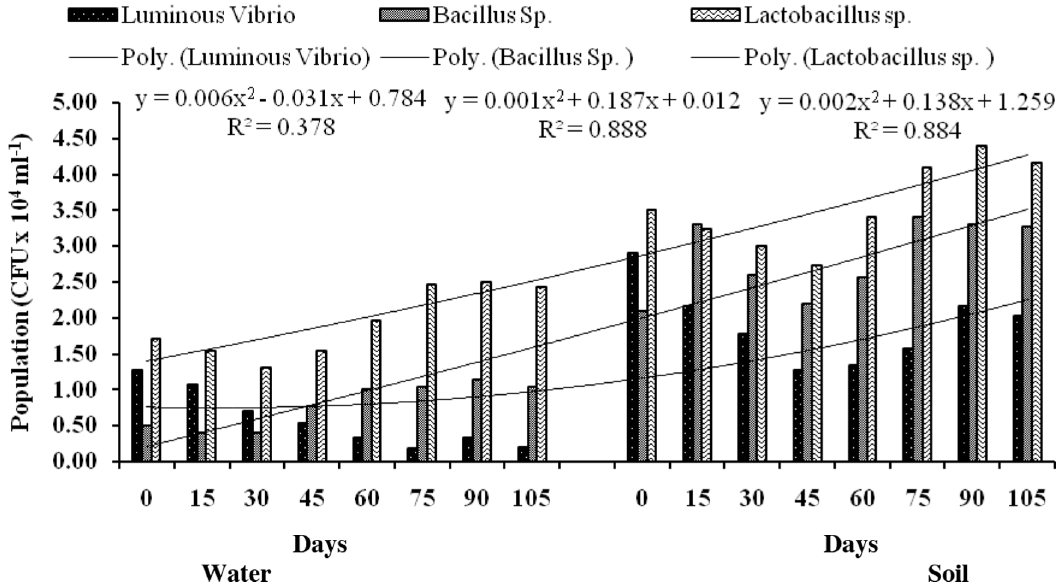
Fig. 3. Fitted relationship of cumulative changes in population of luminous Vibrio sp., Bacillus cereus , Lactobacillus sp. in with neem based bio fl oc culture system of L. vannamei